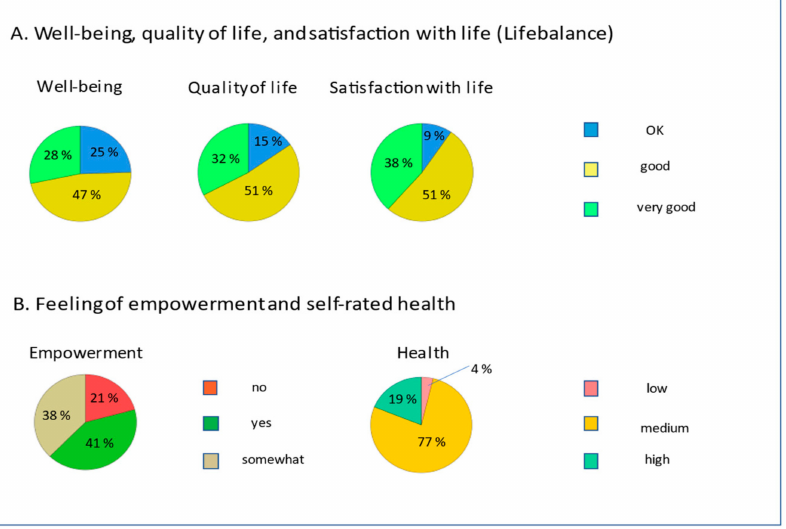
Figure 1. Summary of frequencies: Self-rated health, life balance and feeling of empowerment to face